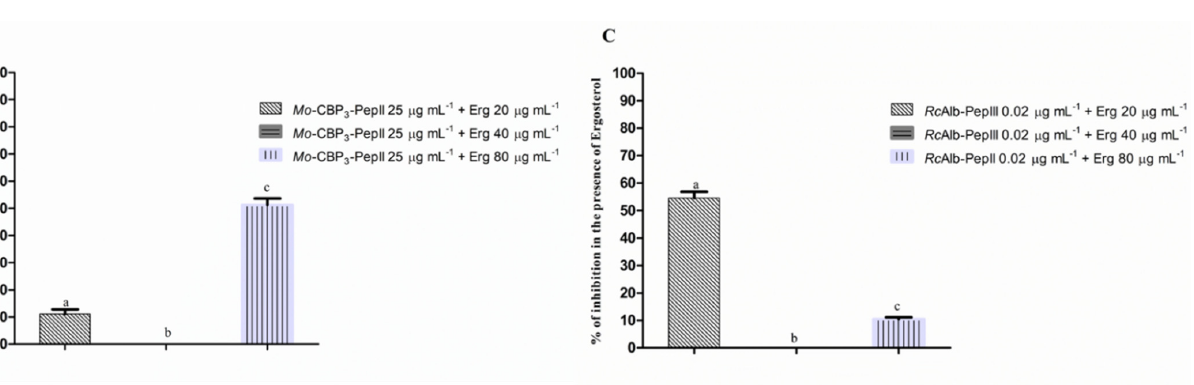
Figure 1. The interaction of ergosterol and its role in the antifungal activity of synthetic peptides. ( A ) Mo -CBP 3 -PepII, ( B ) Rc Alb-PepII, ( C ) Rc Alb-PepIII, ( D ) PepGAT, and ( E ) PepKAA DMSO-NaCl was used as a negative control. Data are presented as mean ± standard deviation (SD). Using the Tukey test, different letters represent the statistical difference ( p < 0.05). The experiment was repeated three times. 3.3. Membrane Pore Formation The presence of pores on C. neoformans membranes was confirmed by propidium iodide (PI) uptake assay. PI interacts with DNA releasing red fluorescence but cannot pass through a healthy membrane. As expected, the healthy membrane of control C. neoformans did not allow the passage of PI and had no red fluorescence (Figure 2). In contrast, the PI uptake and red fluorescence showed that all peptides could induce pore formation on the C. neoformans membrane (Figure 2). PI assay only provides information about the pores on the membrane without any clue about their size. An additional experiment using dextran with a size of 6 kDa conjugated with FITC (Fluorescein isothiocyanate—green fluorescence, Figure 3) revealed